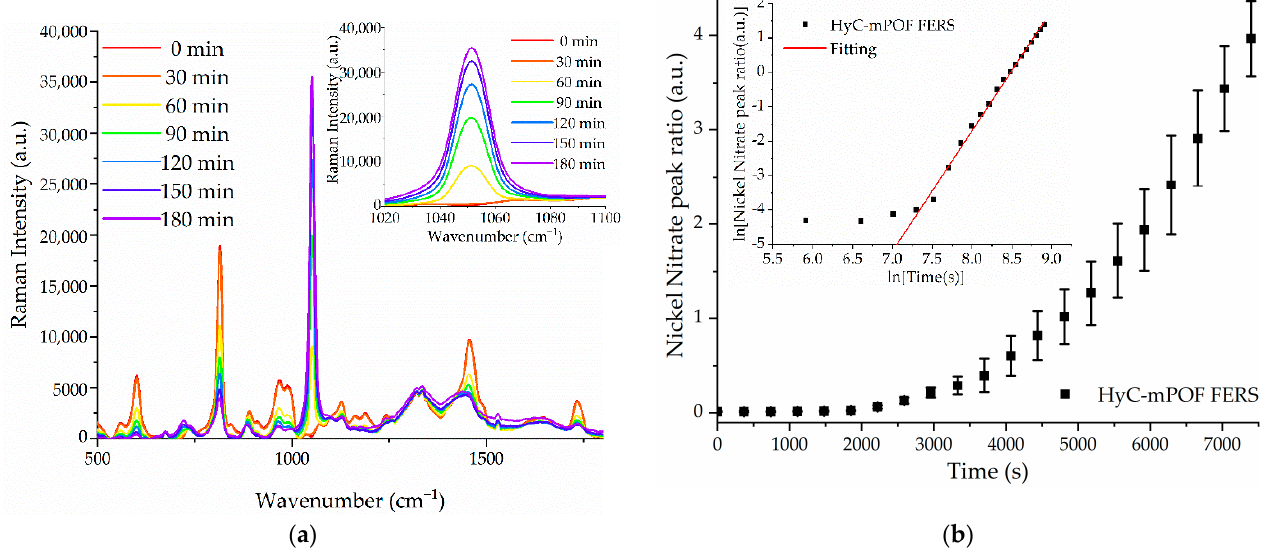
Figure 5. ( a ) Raman spectra progression during 3 h in a nickel nitrate detection measurement. The inset shows the spectral evolution around 1050 cm − 1 in more detail; ( b ) The average values together with their corresponding error bars of the nickel nitrate peak ratio of different measurements. The inset shows the mean value of nickel nitrate peak ratio measurements for a log-log chart and the red line corresponds to its linear fitting with a slope of 3.5 (coefficients of determination of R 2 = 0.994).